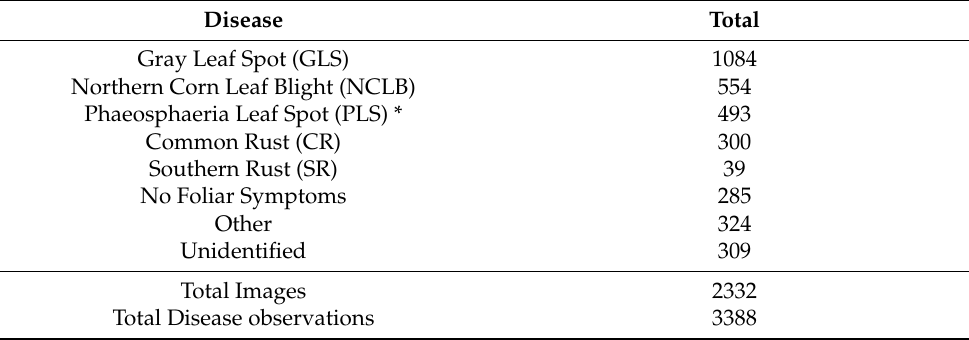
Figure 2. Example images of GLS symptoms on maize leaves in the In-field (IF) dataset. ( a ) Example of GLS lesions as visualized from under the leaf. ( b ) Example of GLS coalescing into larger, differently shaped lesions. ( c ) Example of a GLS lesion (red) occurring inside an NCLB lesion (blue). Table 2 gives a breakdown of the labelled dataset. Table 3 contains a breakdown of the extent of disease co-occurrence within the dataset. Table 2. Breakdown of disease classes found in the In-field dataset.